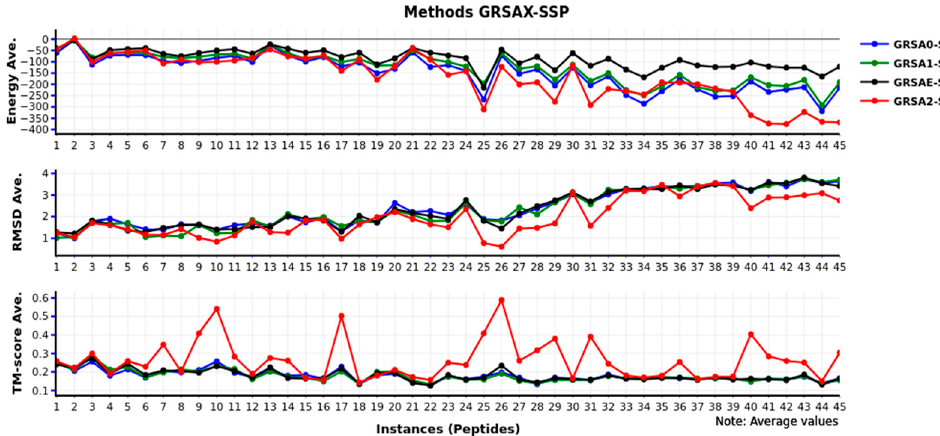
Figure 5. Comparison of GRSA2 versus GRSA2-SSP.